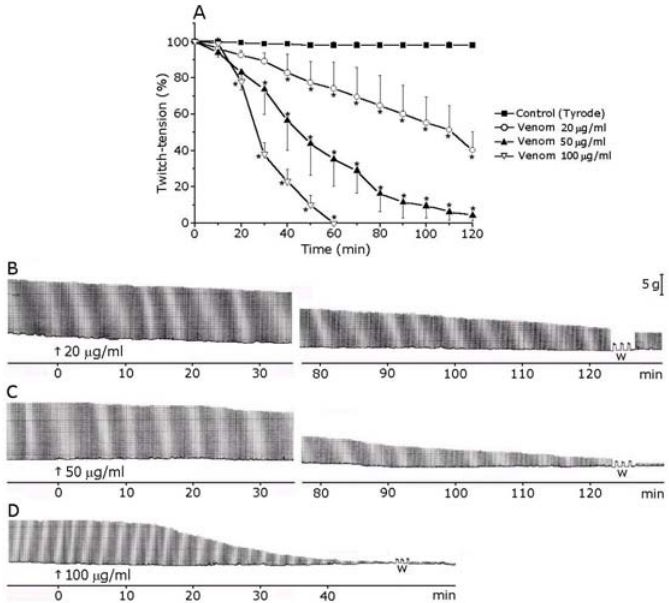
Figure 1. B. n. pauloensis venom effect on indirectly stimulated mouse phrenic nerve- diaphragm preparations. A shows average responses to venom compared to Tyrode control (* p <0.05). Each point represents mean ± S.E.M. of 3-6 experiments. B-D shows responses to venom (added at arrow) in indirectly stimulated preparations. Recordings are representative of 3-6